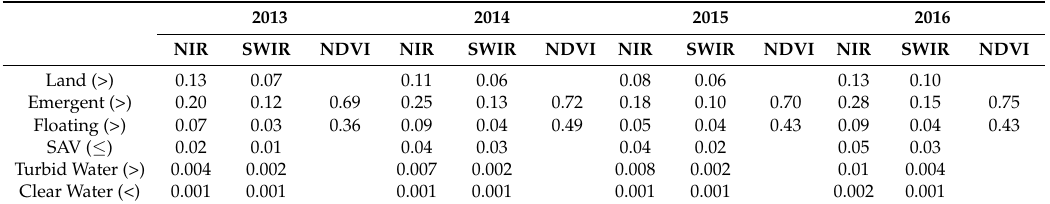
Table 2. Classification thresholds based on the vegetation index and reflectance of NIR and SWIR bands of Landsat-8 atmospherically–corrected images